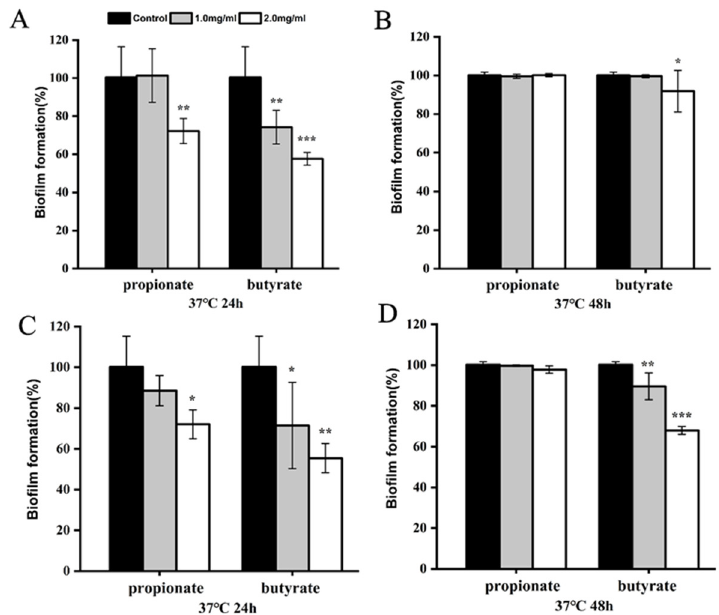
Figure 3. Biofilm formation of S. Typhimurium SL1344 grown in milk model at 37 °C for ( A ) 24 h and ( B ) 48 h, or in chicken broth for ( C ) 24 h, ( D ) 48 h. “*”, “***”, and “***” indicates significance compared to the control. “*” p < 0.05, “**” p < 0.01, “***” p < 0.001.